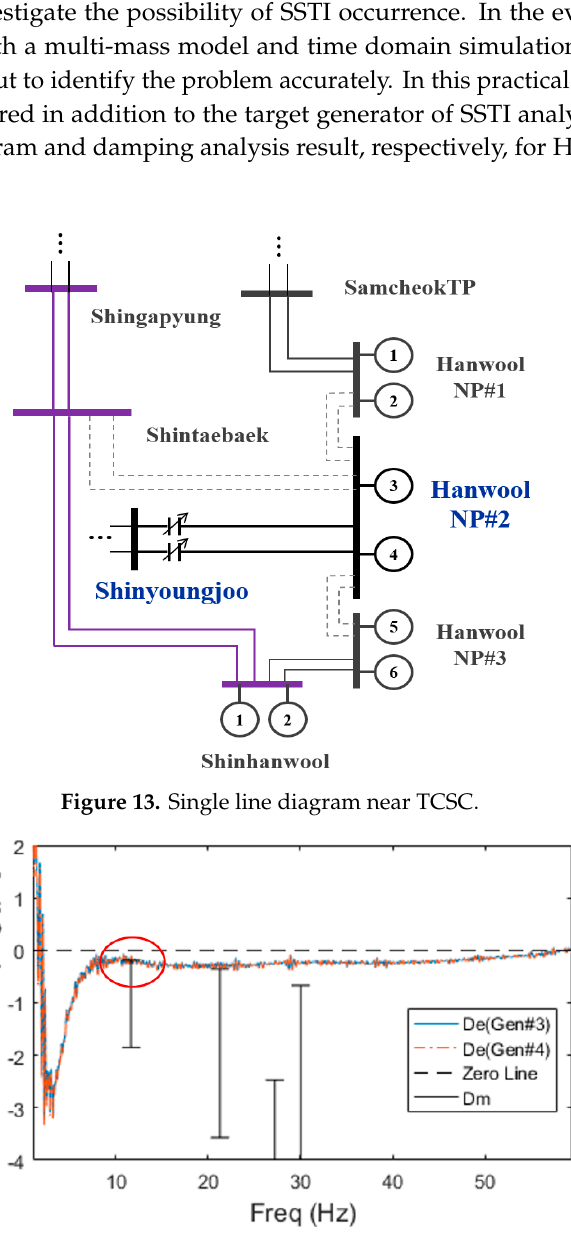
Figure 14. Damping analysis result.